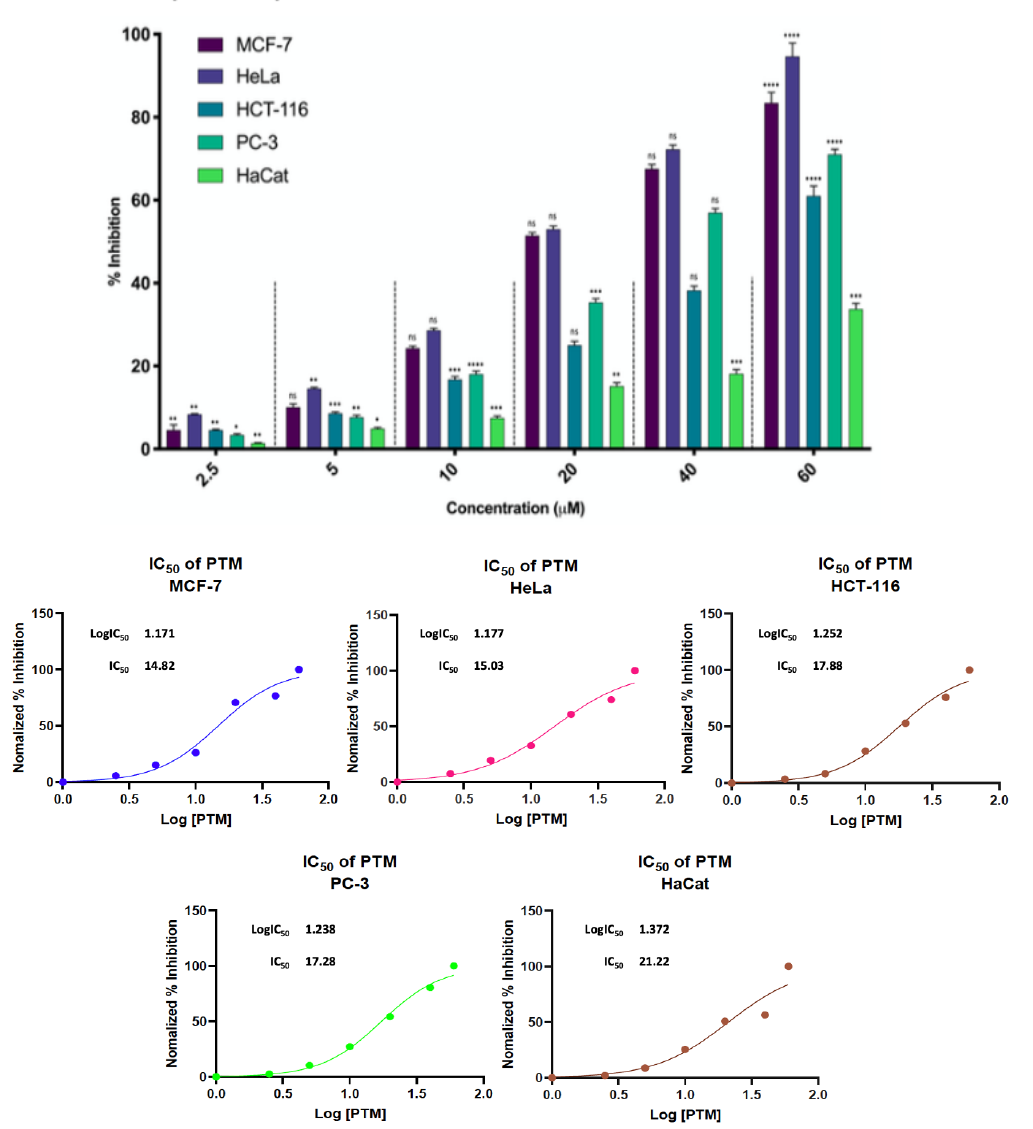
Figure 2. PTM showed highest cytotoxicity in cervical and breast cancer cell lines. Upon treatment of PTM for 24 h on breast (MCF-7), cervical (HeLa), colorectal (HCT-116) and prostate (PC-3) cell lines, % inhibition of ~96% of HeLa and ~82% of MCF-7 cells was observed. Additionally, PTM treated HCT-116 and PC-3 showed % inhibition of ~60% and ~70%, respectively. The anti-cancer activity observed in all the cell lines was dose-dependent. PTM showed ~40% growth inhibition in normal human keratinocyte, HaCat, cell line. In addition, the number of cells were much lesser in the PTM treated groups. n = 3, mean ± SEM, p value of <0.05 was considered to be significant, * p ≤ 0.05, ** p ≤ 0.01, *** p ≤ 0.0001, **** p ≤ 0.00001 and ns = not significant. The IC 50 values of PTM on MCF-7, HeLa, HCT-116, PC-3 and HaCat were observed to be 14.82, 15.03, 17.88, 17.28 and 21.22 micromoles, respectively.